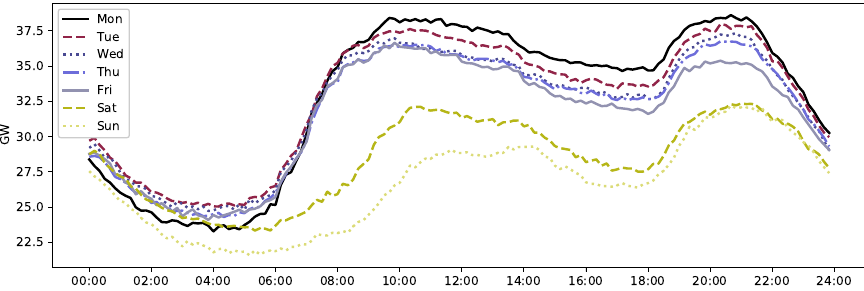
Figure 1. Line plots illustrating the electric demand time series data at different